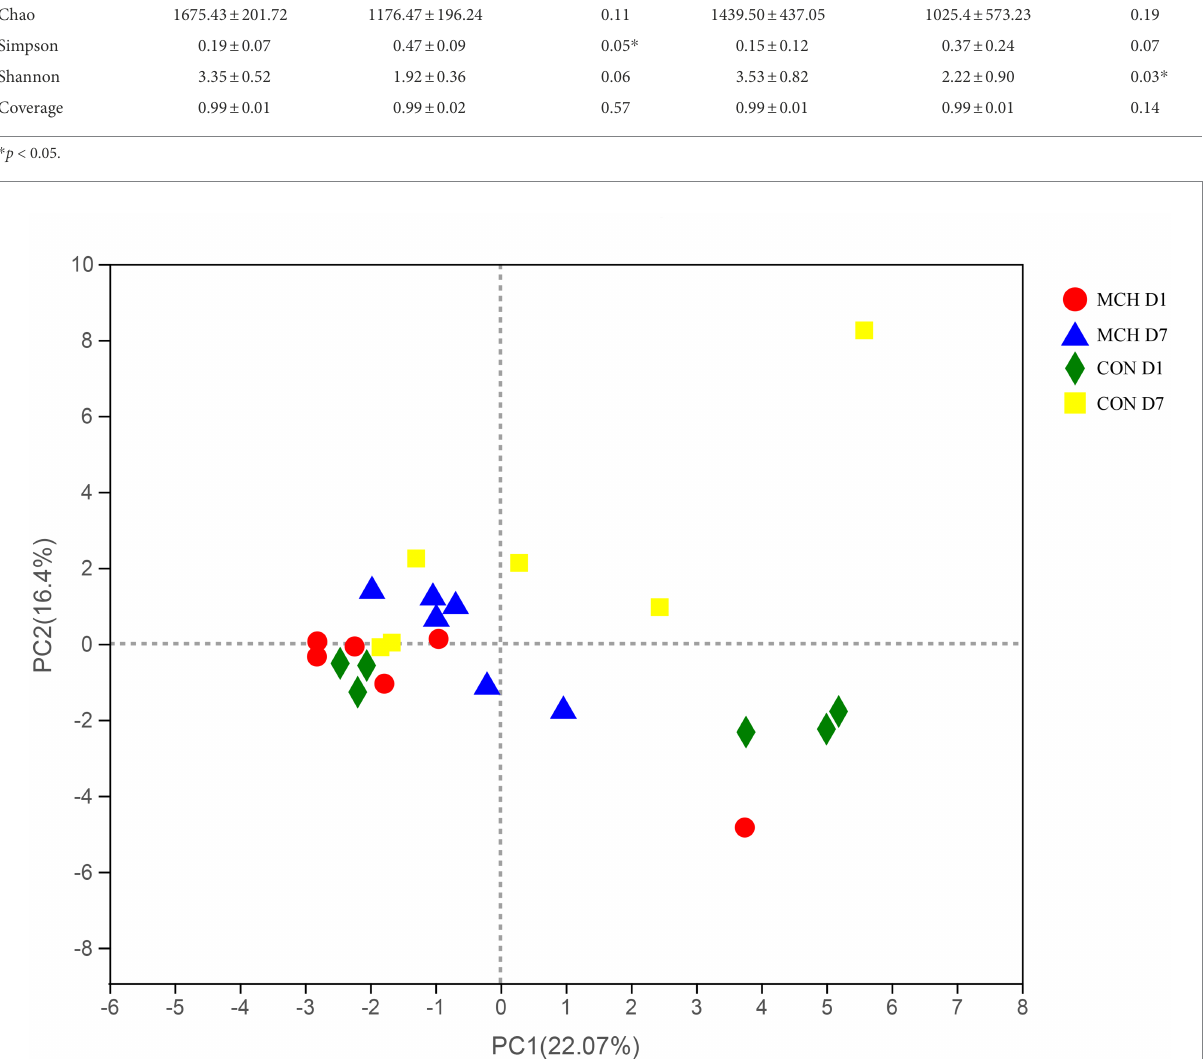
FIGURE 1 PCA of milk microbial communities from cows with subclinical mastitis between MCH group and CON group from day 1 to day 7 ( n =